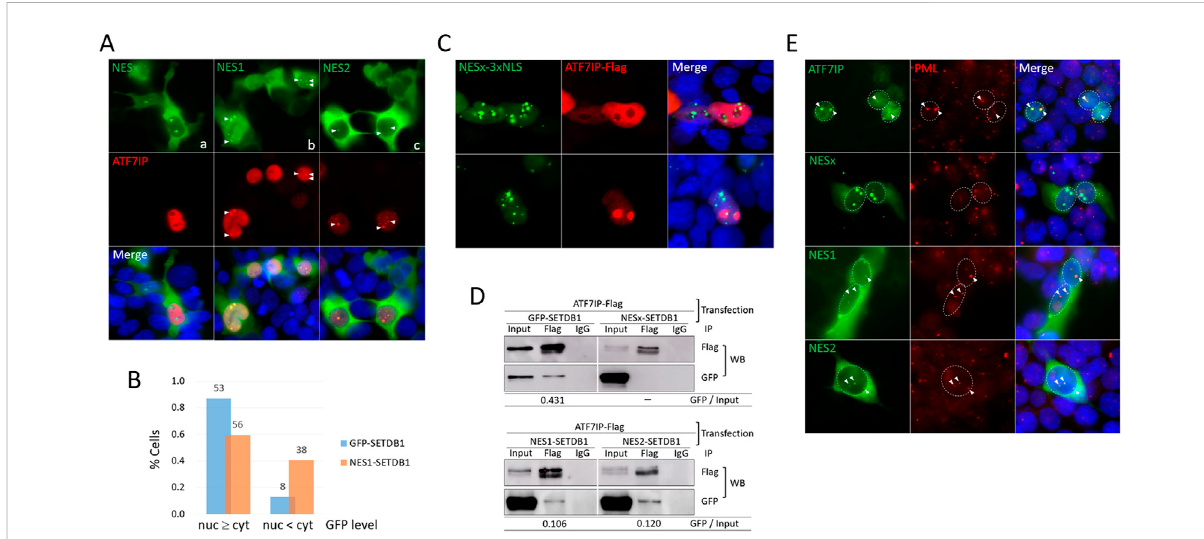
The NES1 motif is necessary for ATF7IP-mediated nuclear localization of SETDB1 (A) Effect of NES motifs on SETDB1 movement in ATF7IP- overexpressing 293T cells. Arrowheads point to nuclear dots overlapped between cells expressing NES variants and ATF7IP-Flag. (B) Comparison of ATF7IP-inducednuclearlocalizationef fi ciencybetweenGFP-SETDB1andNES1-SETDB1.Thefractionsofcellswithhigh(nuc ≥ cyt)orlow(nuc < cyt) nuclear GFP levels compared with cytoplasmic GFP levels were calculated. The counts in the bars indicate the number of cells examined. The results of two independent experiments were summed. (C) Discordant localization of NESx-3xNLS-SETDB1 and ATF7IP in the nucleus. (D) Immunoprecipitation (IP)of the NES variants using an anti-Flag antibody.293T cells were co-transfected with ATF7IP and the indicated NES variants priortoIP.TheIPef fi ciencywasobtained bycalculatingtheprecipitatedGFPbanddensityrelativetotheinputGFPbanddensity(GFP/input). (E) PML localization of NES variants in 293T cells. Cells were co-transfected with the indicated NES variant constructs and ATF7IP-Flag and stained using